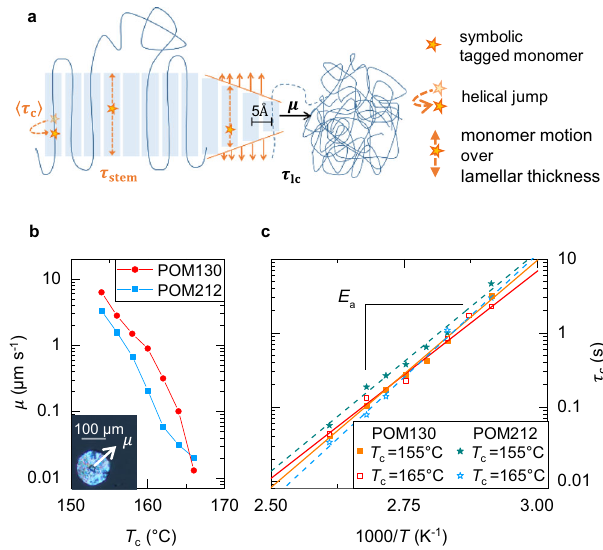
Fig. 1 Competing timescales of crystal growth ( τ lc ) and intracrystalline chain dynamics ( 〈 τ c 〉 , τ stem ). a Schematic illustration of the crystallization process with τ lc , 〈 τ c 〉 , and τ stem . b Growth velocity μ of poly(oxymethylene) for two molecular weights (POM130 and POM212) as a function of crystallization temperature T c . The inset illustrates how μ is determined from the growth of spherulites during isothermal crystallization. c Arrhenius temperature dependence of the jump correlation time 〈 τ c 〉 for two molecular weights (POM130 and POM212) isothermally crystallized at different T c